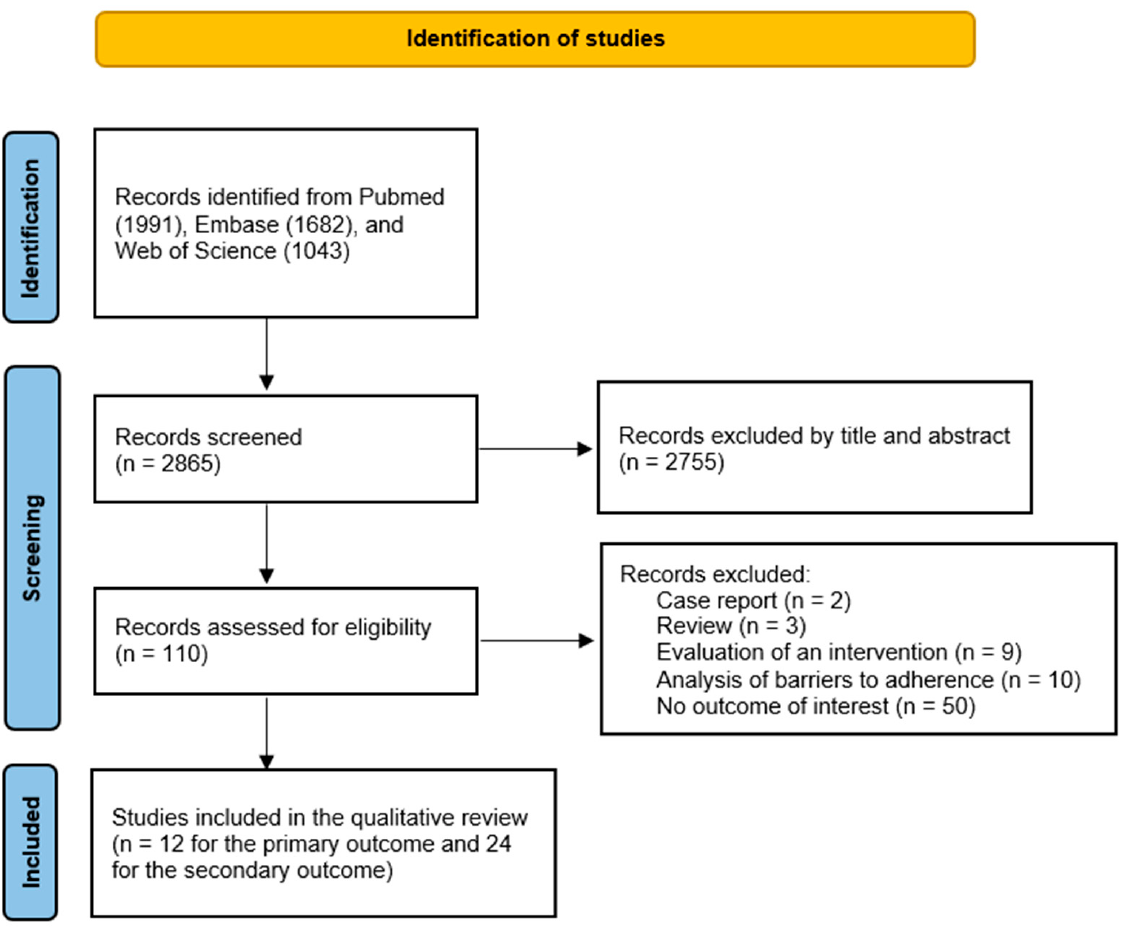
Figure 1. PRISMA flow diagram.